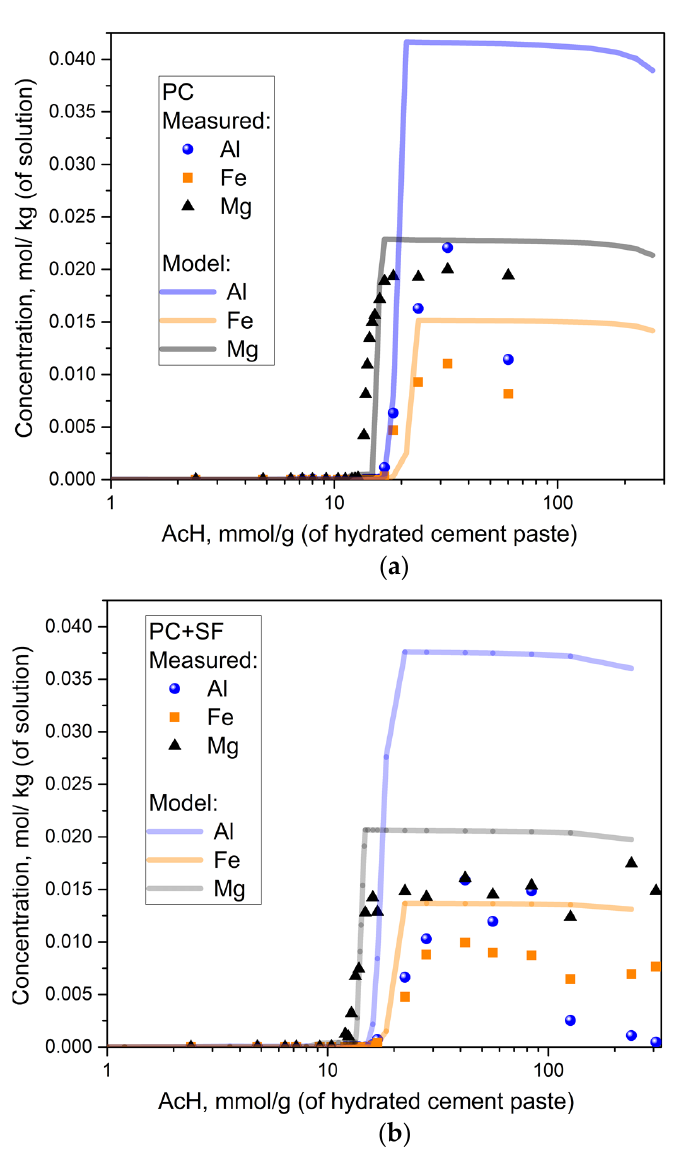
Figure 3. Concentration of dissolved calcium as a function of acid concentration, both for PC and PC + SF.